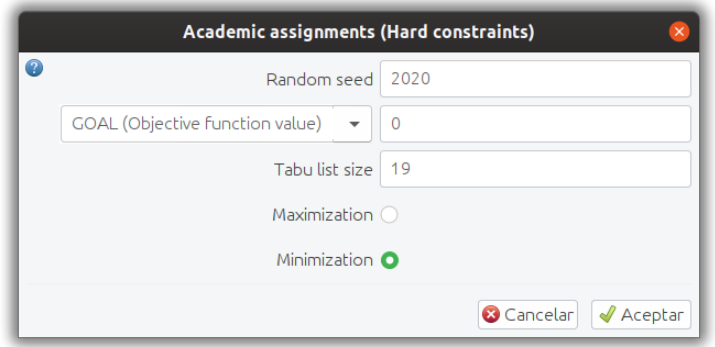
Figure 10. A configuration of the Tabu Search with Probabilistic Aspiration Criterion (TS-PAC) parameters for the Academic assignments (ACA) phase (hard constraints).